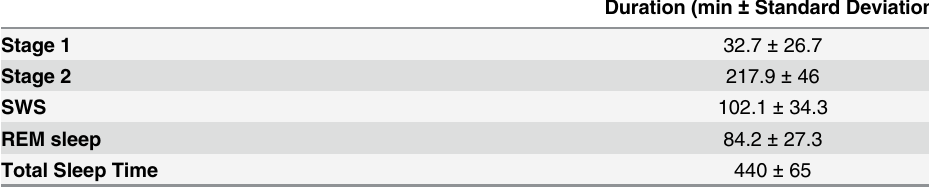
Table 2. Total time spent in sleep